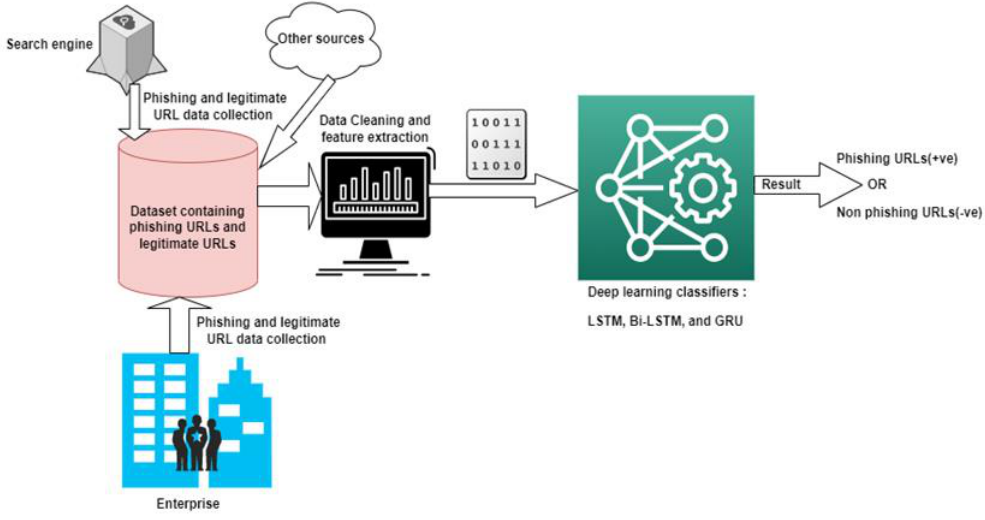
Figure 1. Conceptual architecture of the three proposed models for detecting phishing URLs.